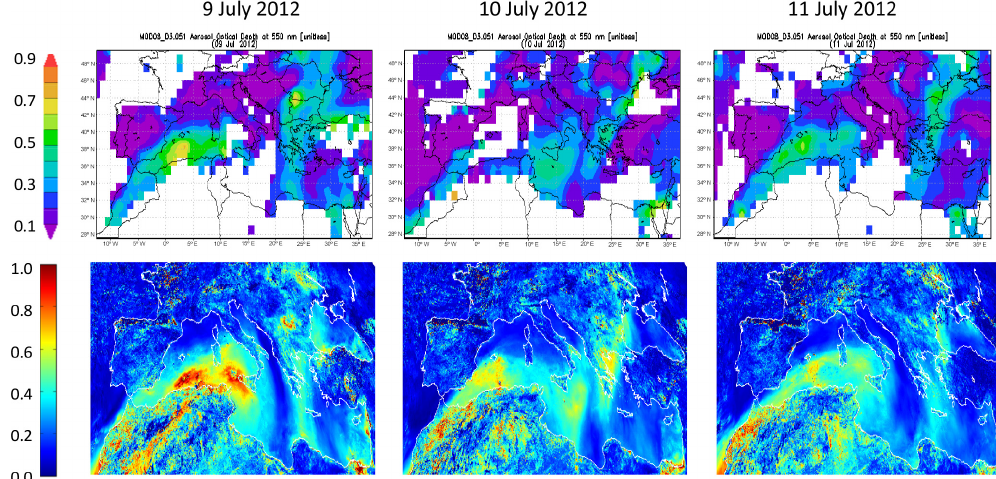
Figure 9. τ 550nm from MODIS/Terra (top) and τ 675nm daytime mean from MSG-SEVIRI (bottom) on 9, 10, and 11